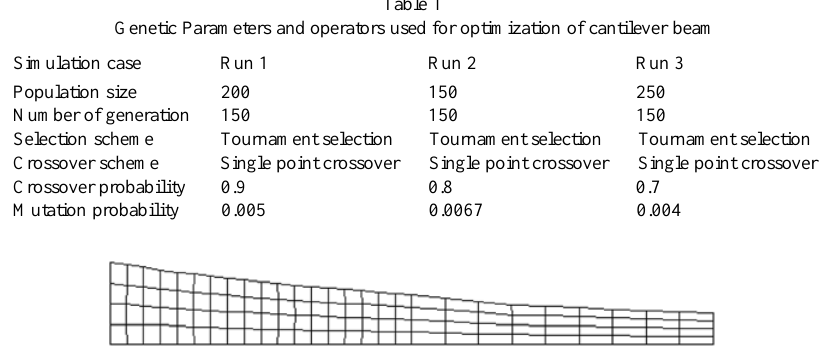
Fig. 6. Final shape of the optimized cantilever